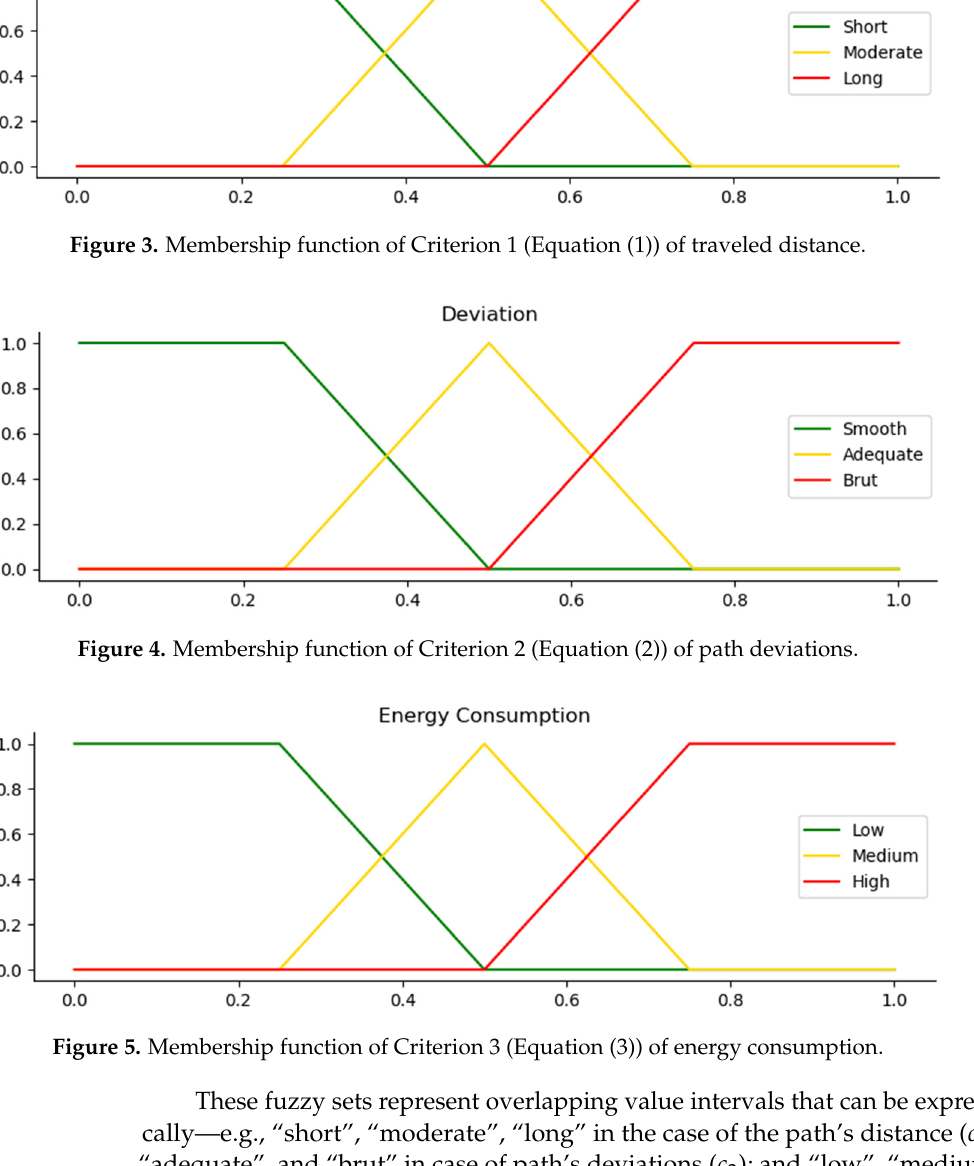
Figure 6. Membership function of the overall quality of the path. Table 1. The fuzzy rules adopted for the FIS.